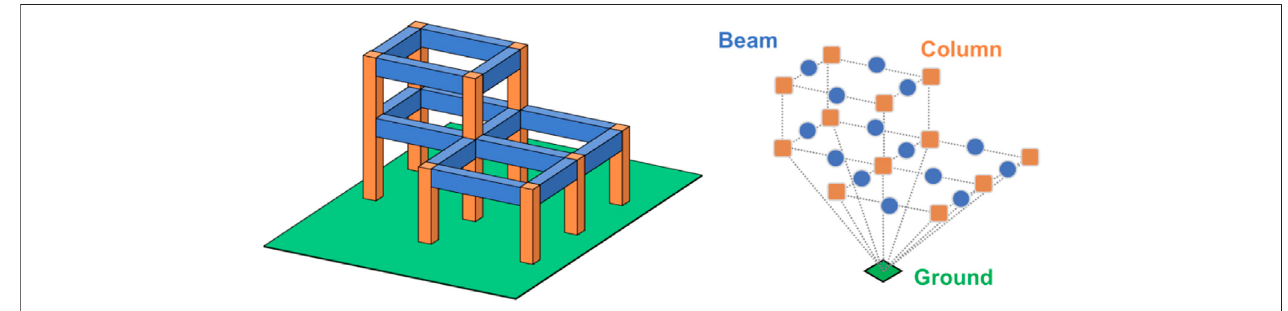
FIGURE 6 | An example building structure and its structural graph representation suitable for analysis by GNN, from Chang and Cheng (2020).